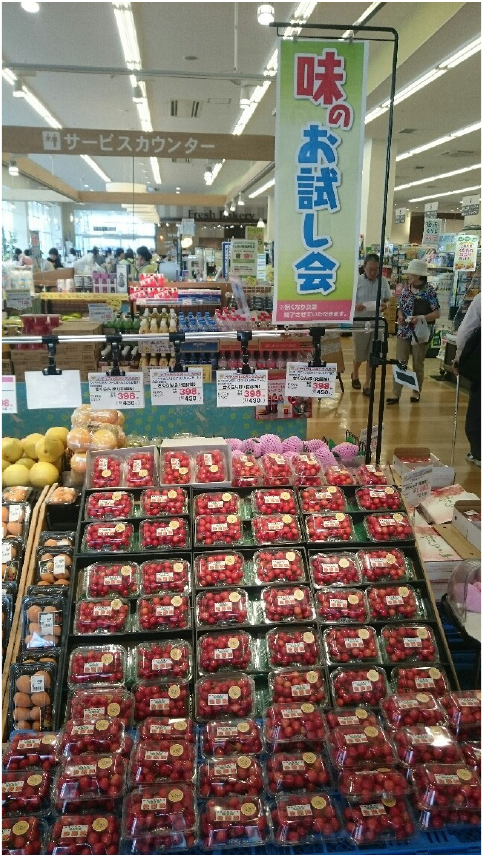
Figure 5. How vegetables and fruits are sold in a supermarket run by Company